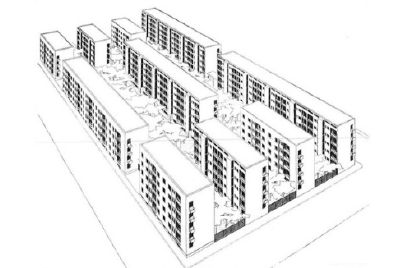
Figure 10 Site Perspective. By Franco Albini, Renato Camus and Giancarlo Palanti. 1935. (Archivio Fondazione Franco Albini, Milan.)